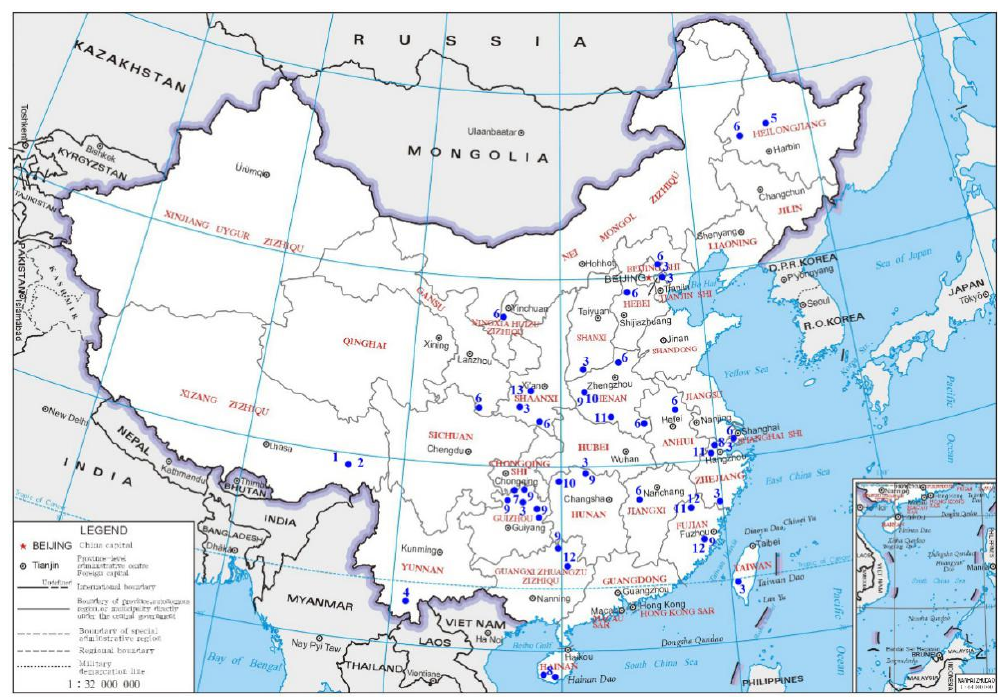
Figure 2. Distribution of the species of Rhopalovalva from China. 1. R. stilliformis sp. nov.; 2. R. spinata sp. nov.; 3. R. catharotorna (Meyrick, 1935); 4. R. connata Zhang, Bai & Li, 2017; 5. R. exartemana (Kennel, 1901); 6. R. grapholitana (Caradja, 1916); 7. R. lacivana (Christoph, 1882); 8. R. macrocuculla Zhang, Bai & Li, 2017; 9. R. orbiculata Zhang & Li, 2004; 10. R. ovata Zhang & Li, 2004; 11. R. pulchra (Butler, 1879); 12. R. rhombea Zhang & Li, 2010; 13. R. triangulata Zhang & Li, 2010